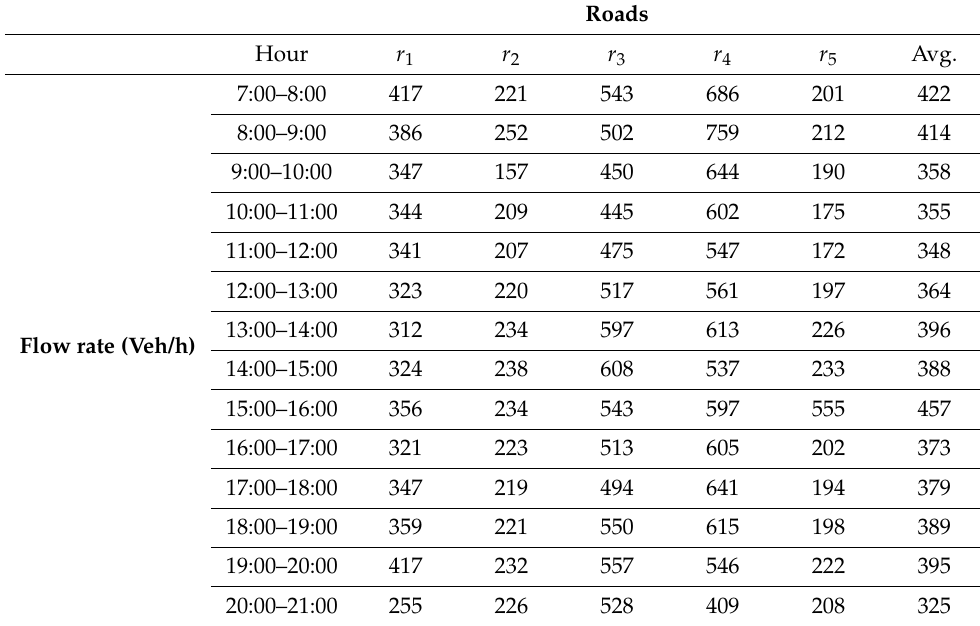
Table 3. Summary of the traffic survey, focusing on the average hourly flow rates per road.